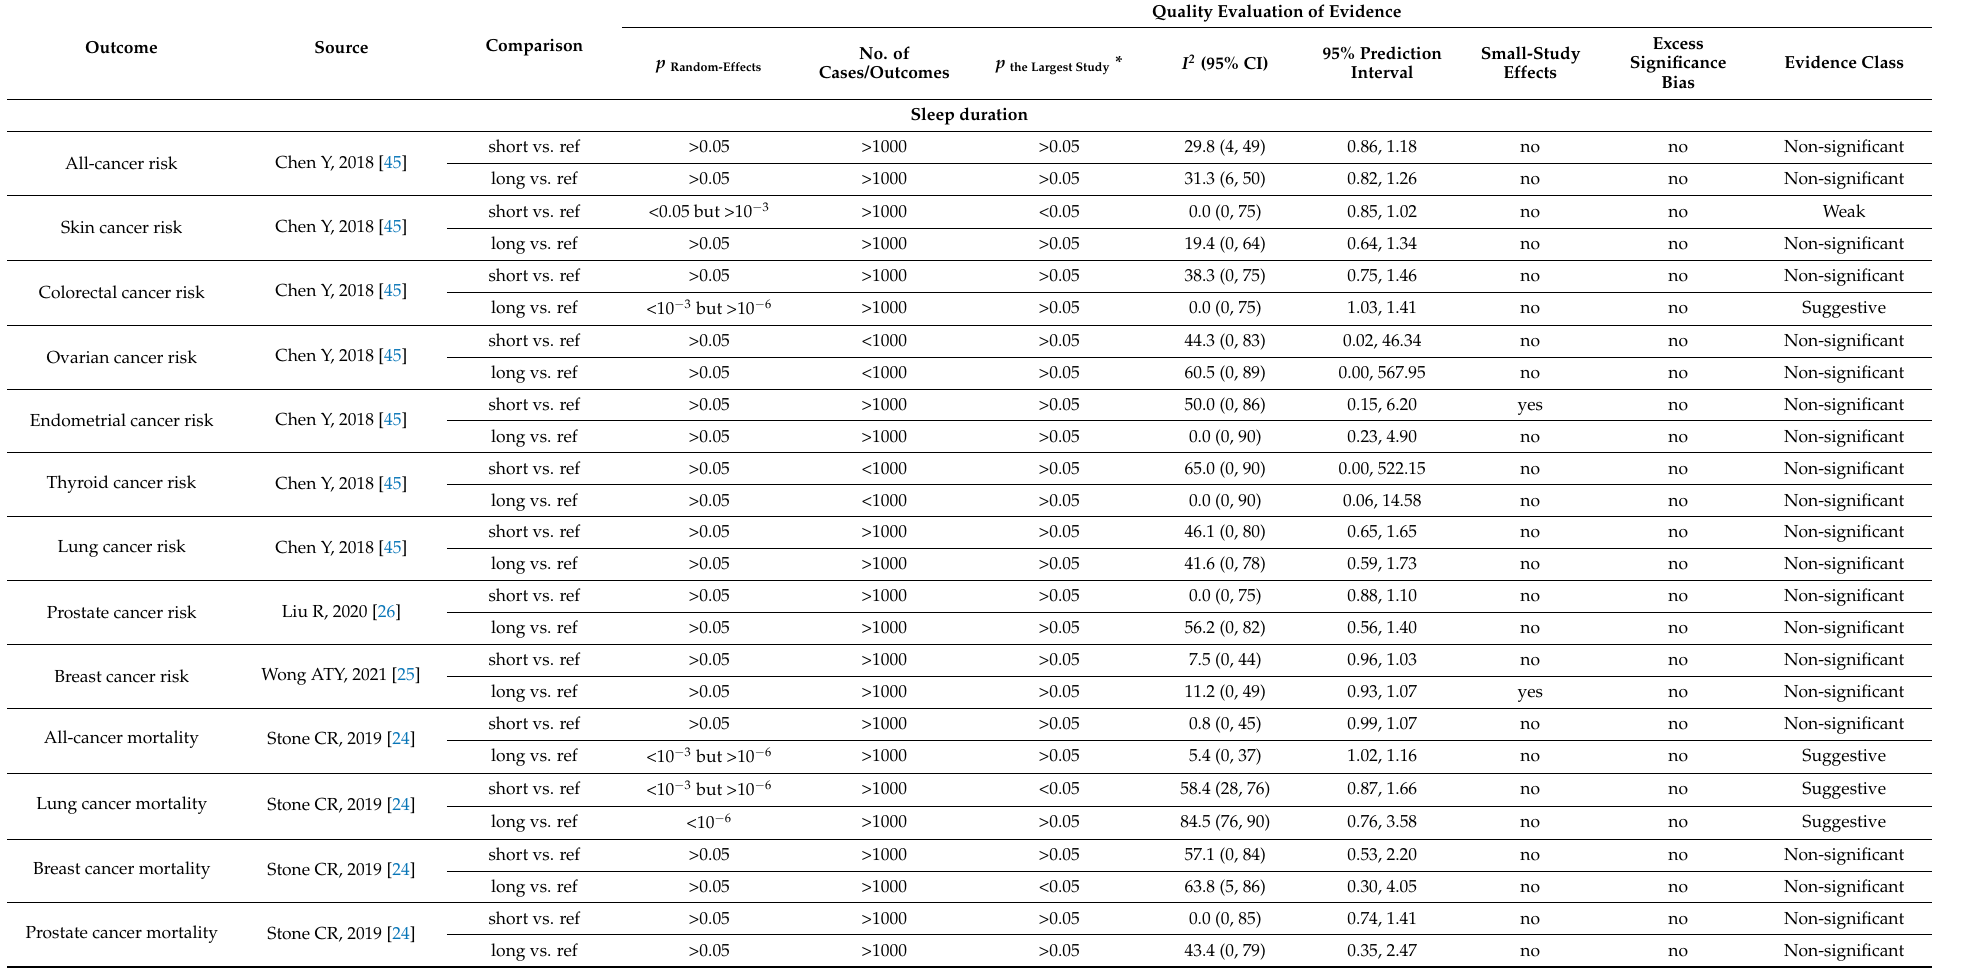
Table 2. Evidence evaluation of associations between sleep characteristics and cancer-related